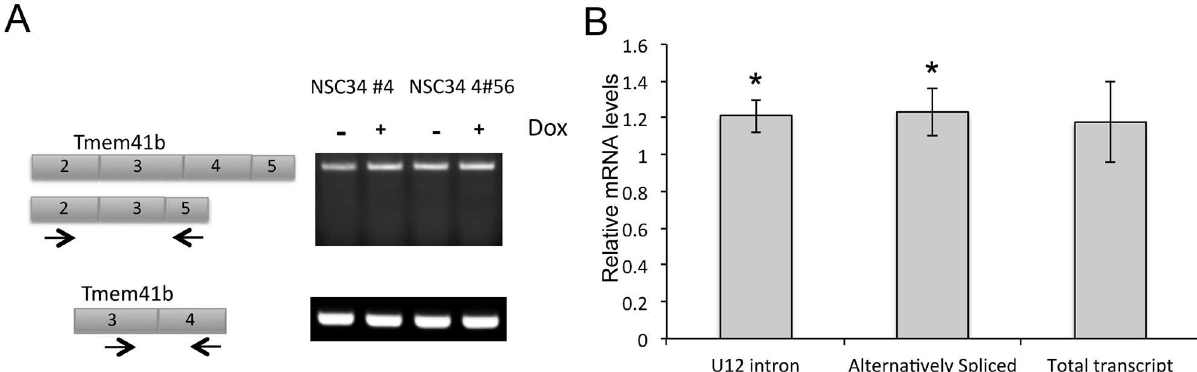
Fig 4. Tmem41b is alternatively spliced in SMN-depleted NSC-34 cells. A) EndpointRT-PCR shows no alternative splicing of Tmem41b or retention of the U12 dependentintron 3 in either parentalcell line NSC-34 #4 or the doxycycline-inducibleSMN knockdown line NSC-34 #4–56 following72 hours of doxycycline. B) Quantitative RT-PCR shows a significant 20% increase in U12 intron retention and alternative splicing in Tmem41b after doxycycline-inducedSMN depletionbut no decrease in total Tmem41b levels. * – p < 0.05 by Student’s